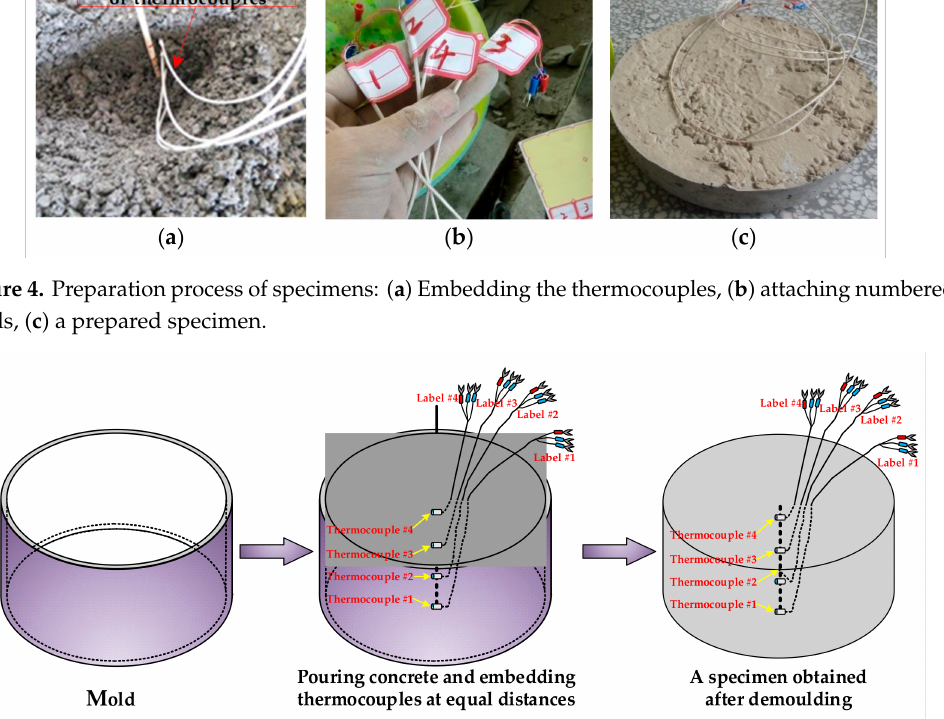
Figure 5. The simplified flow-process diagram for sample preparation. Table 5. Grouping of the cylindrical specimens for the thermal insulation